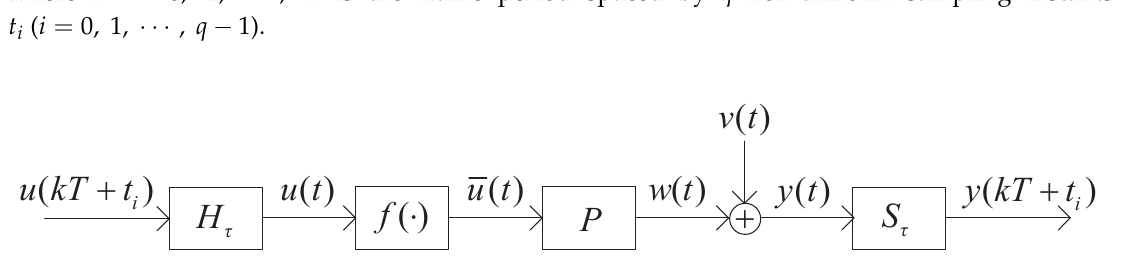
Figure 1. Periodically non-uniformly sampled-data Hammerstein